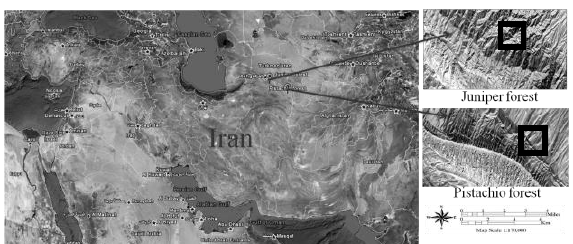
Figure 1. Locations of the study areas in northeast